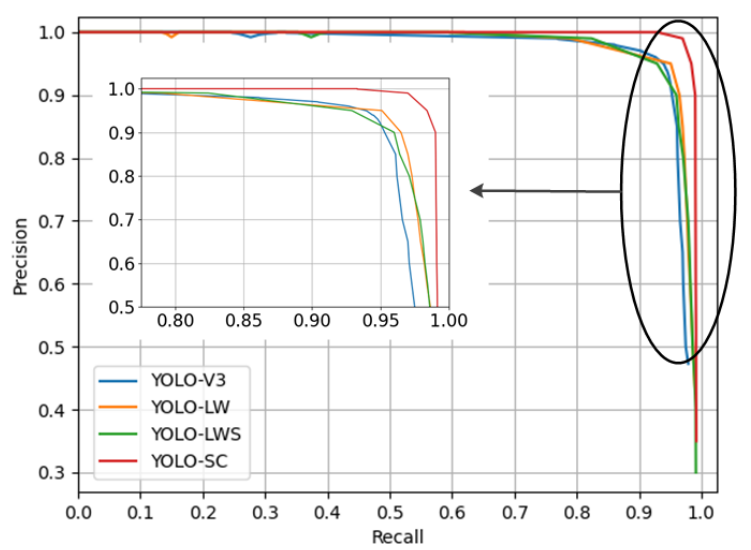
Figure 16. P-R curves for each model in the ablation experiment (top left is a magnification of the circled part on the